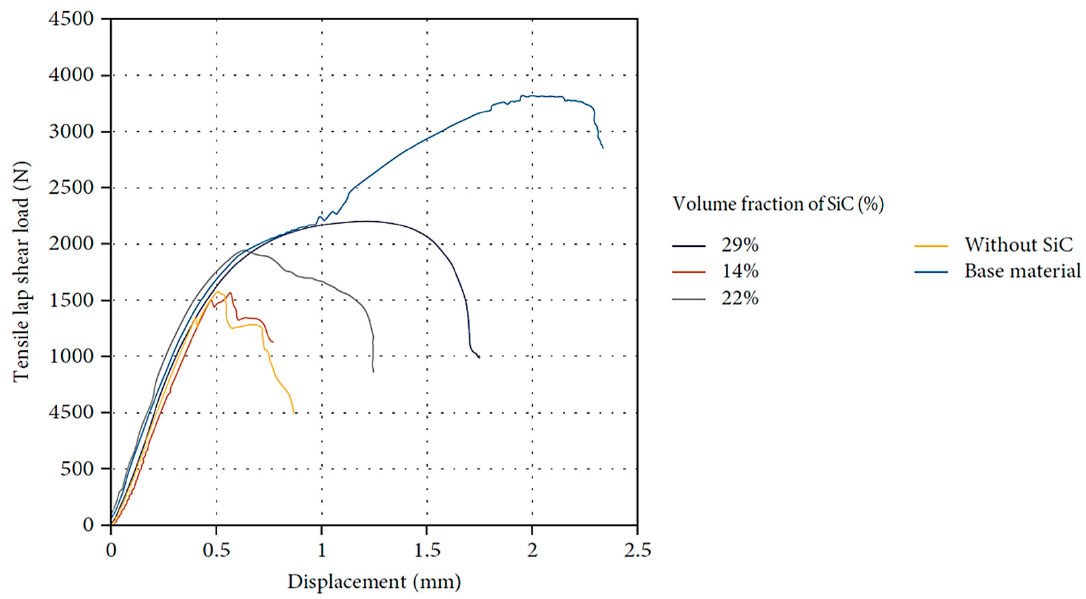
Figure 12. Tensile shear load with varying amounts of SiC nanoparticles [72] .